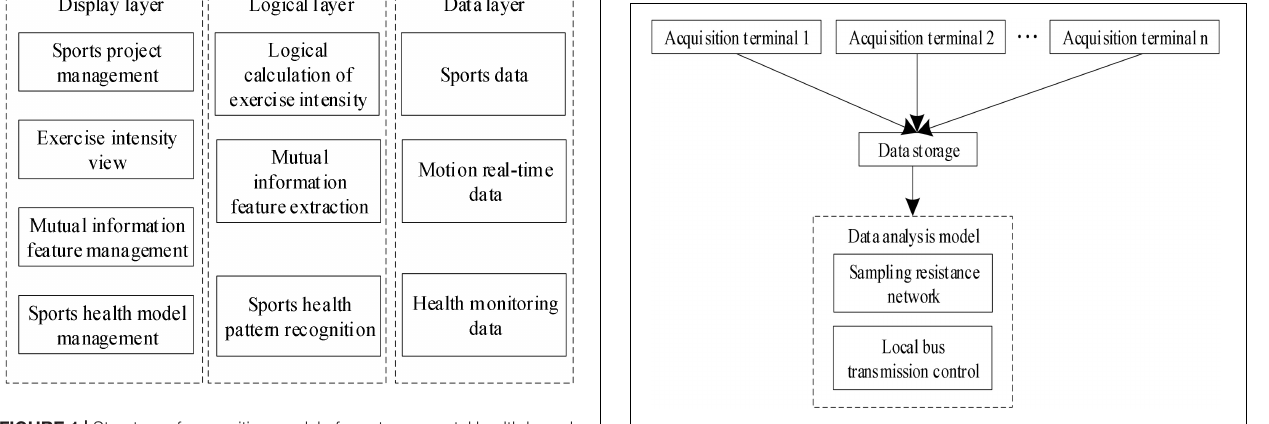
FIGURE 1 | Structure of recognition model of sports on mental health based on deep learning. FIGURE 2 | Data acquisition module of sport load state